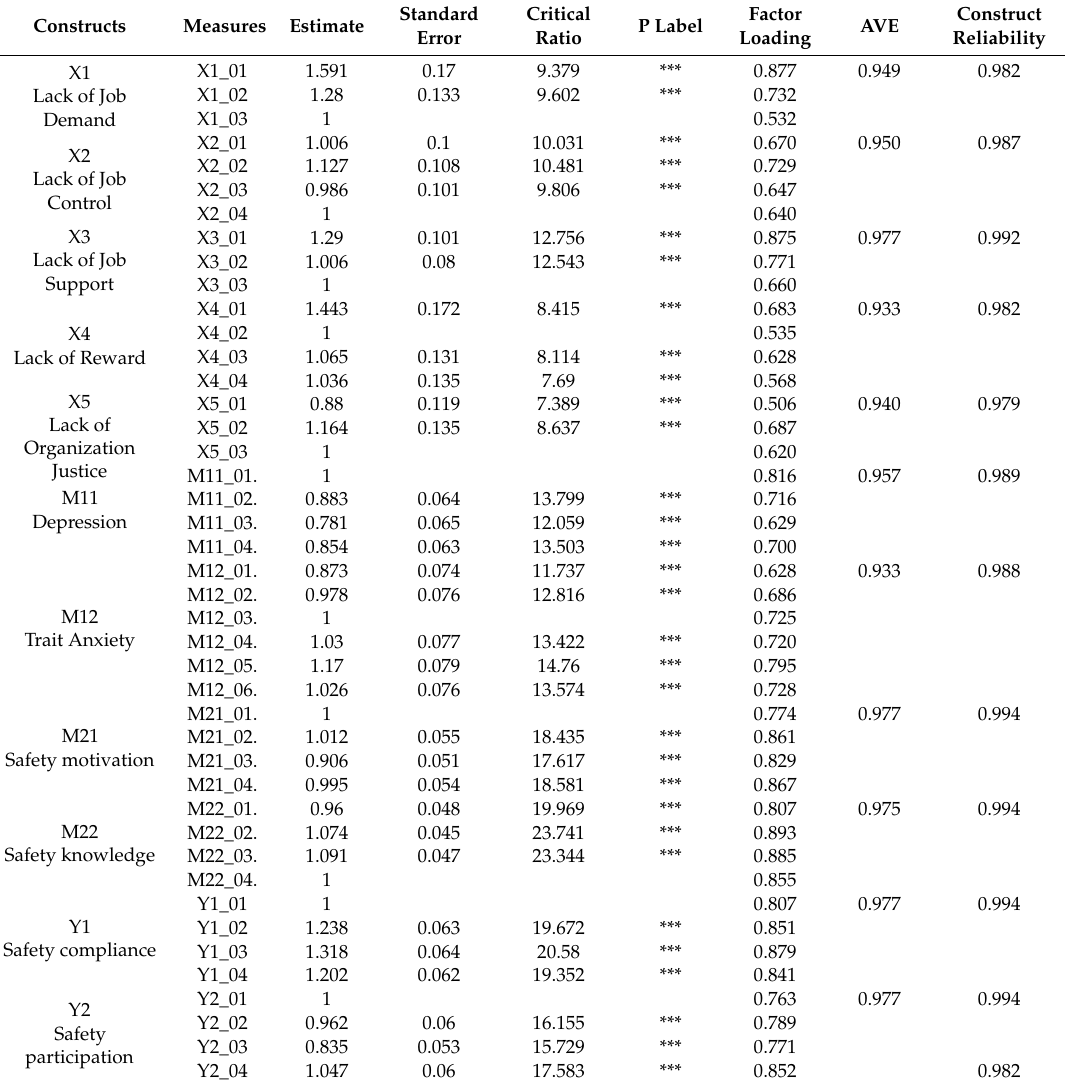
Table 7. Results of the validity test of the measurement